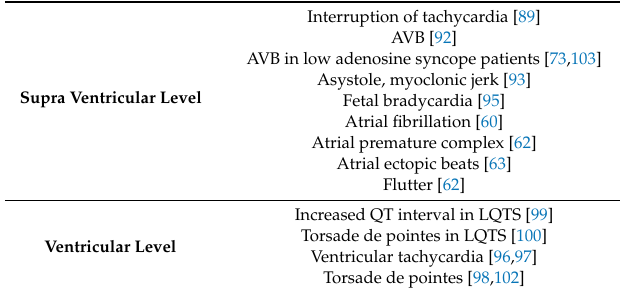
Table 2. Main e ff ects on heart rhythm after exogenous adenosine